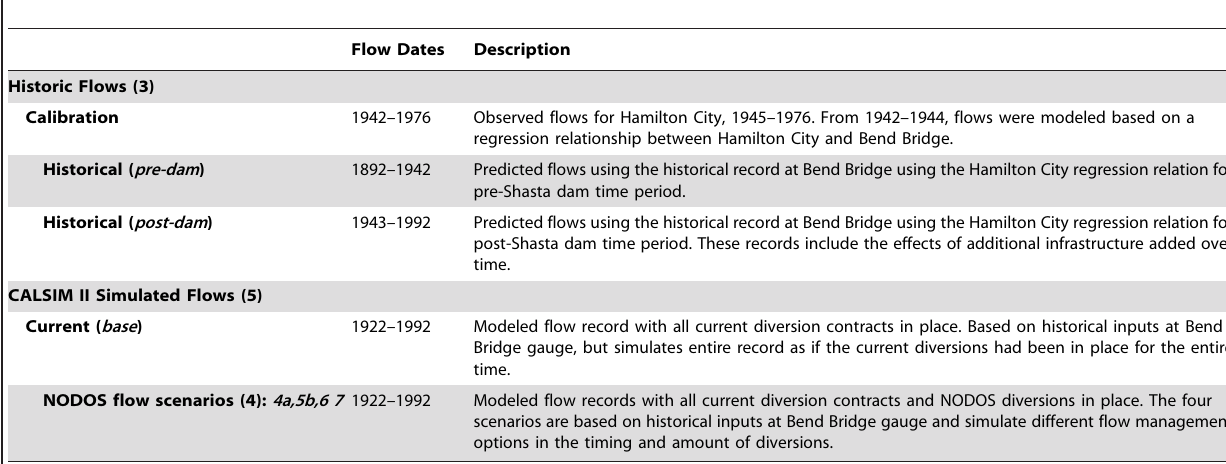
Table 1. Description of flow records (daily mean discharge) measured at USGS Bend Bridge Gauge # 1137100 and Hamilton City # 11388500, and five simulated flows using the CALSIM